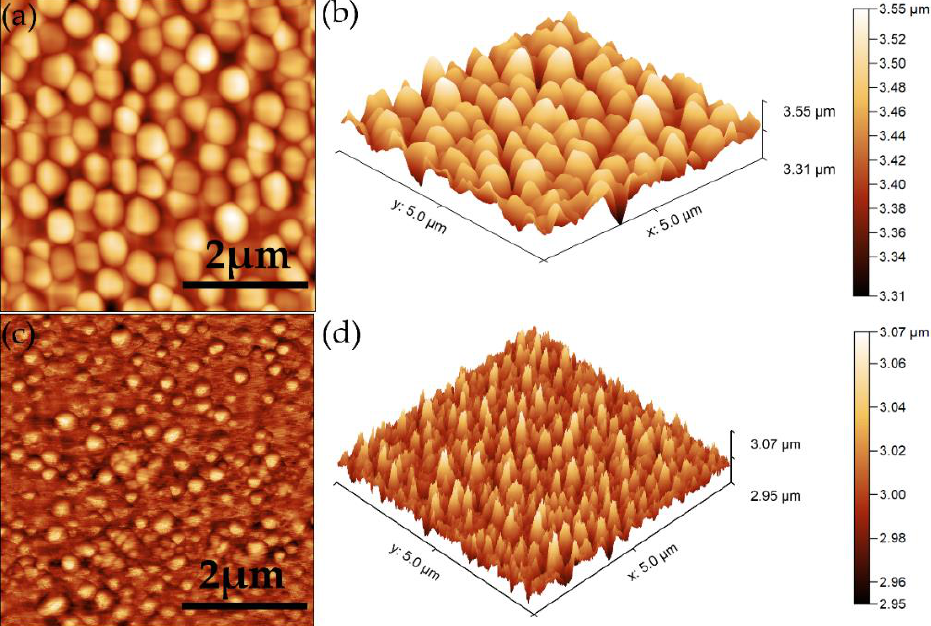
Figure 7. Typical 2D AFM images of surface topography obtained on 5CeHAp-D ( a ) and 10CeHAp- D ( c ) composite thin films and their 3D representation ( b , d ).